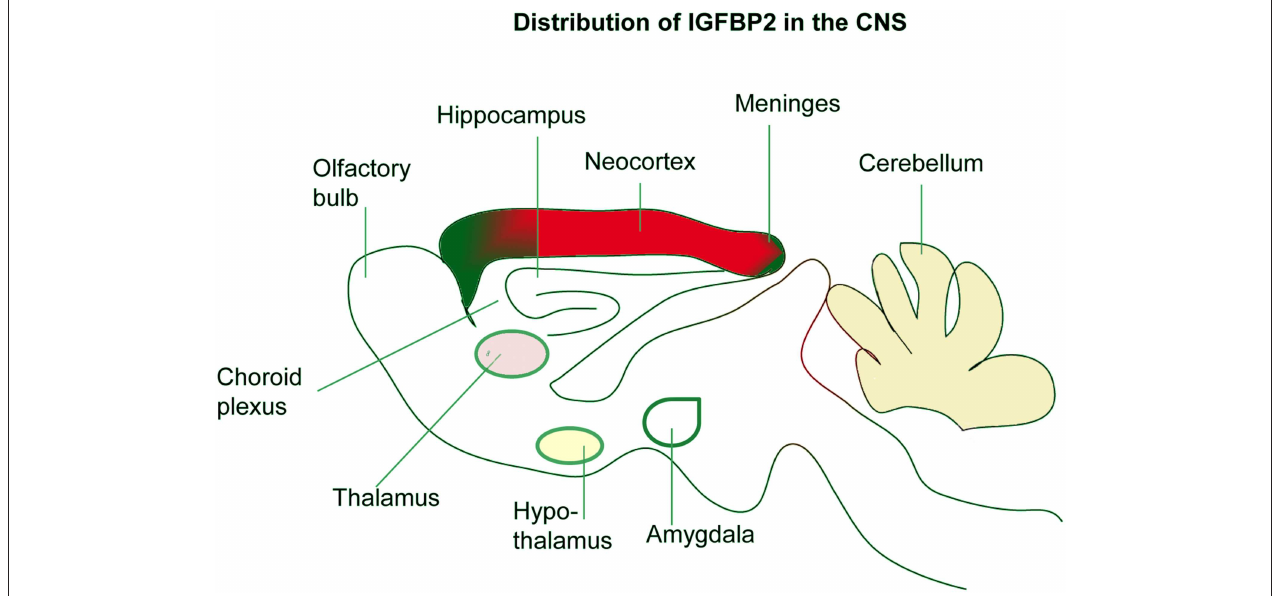
FIGURE 2 | Localization of IGFBP-2 in the brain. IGFBP-2 is abundantly expressed in the hippocampus, neocortex, olfactory bulb, and cerebellum. IGFBP-2 is also found in the meninges, choroid plexus, thalamus, hypothalamus, and amygdala.